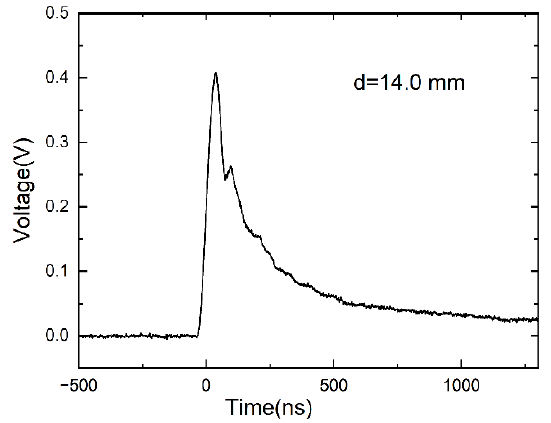
Figure 5. Waveform of the spark discharge optical pulse.